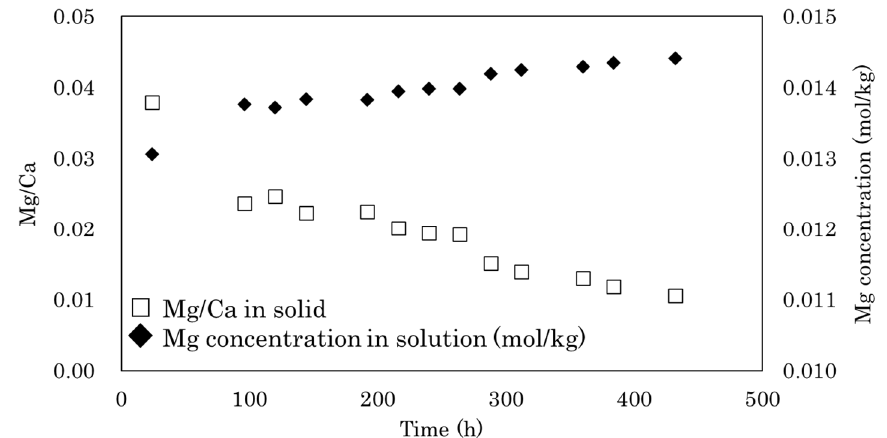
Figure A1. Changes in Mg concentration and Mg / Ca ratio over time during monohydrocalcite synthesis at 5 ◦ C. The initial solutions were 0.015 mol / kg in MgCl 2 , 0.015 mol / kg in CaCl 2 , and 0.08 mol / kg in Na 2 CO 3 .